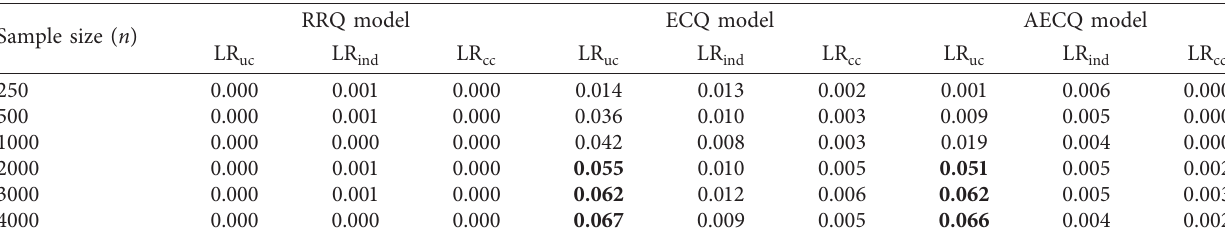
Table 4: P values for the likelihood ratio